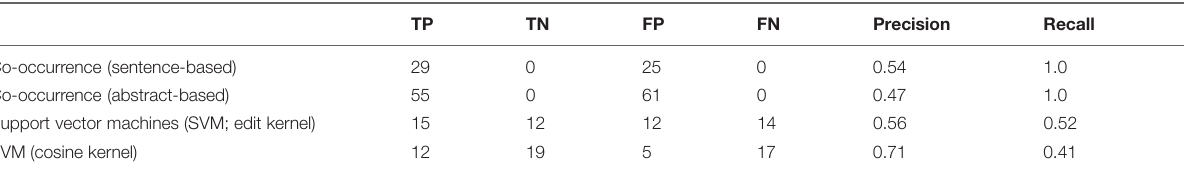
TABLE 1 | Co-occurrence and machine learning based host- Brucella gene–gene interaction results.